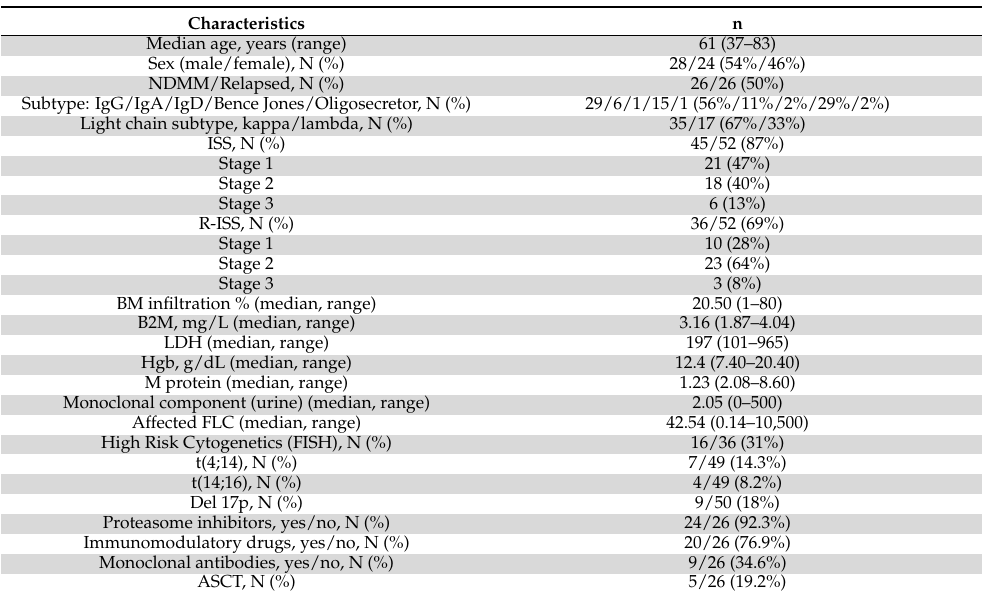
Table 1. Patients’ characteristics.